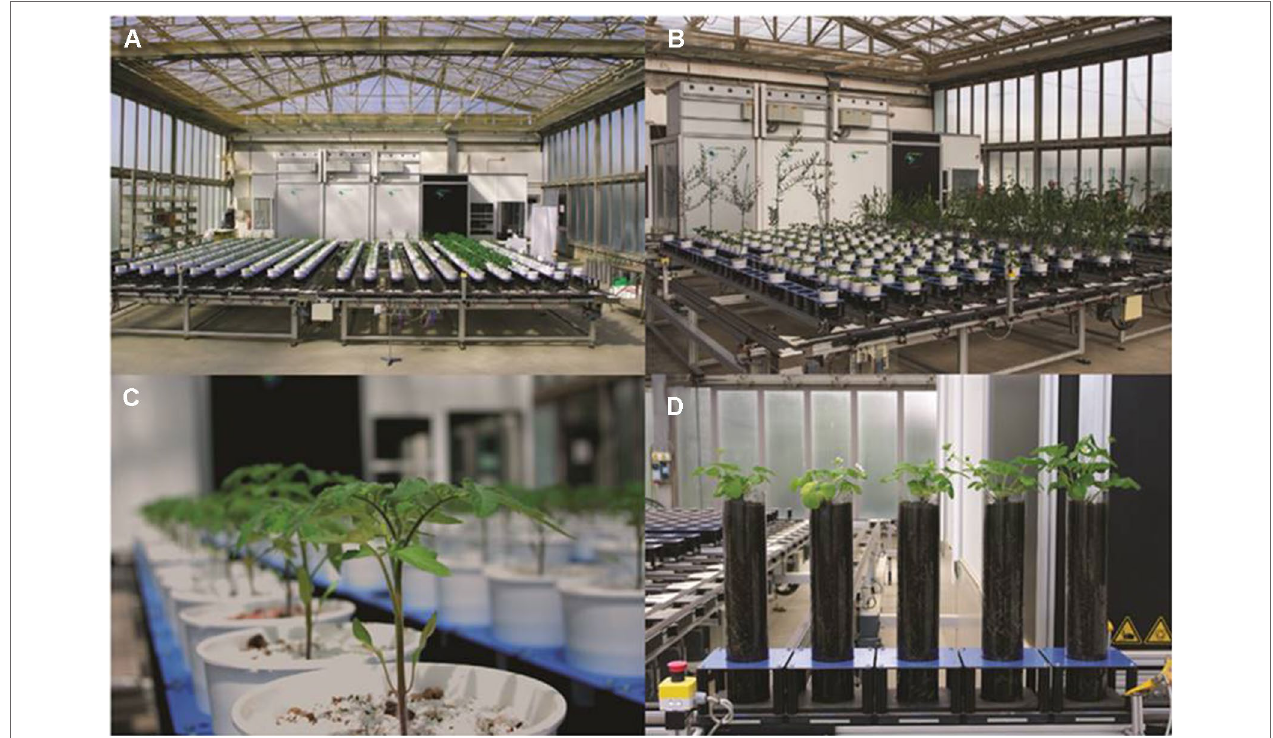
FIGURE 3 | The ALSIA greenhouse phenotyping facility (Basilicata, southern Italy) consisting of Scanalyzer 3D-systems which include conveyor belts (0.3 km and 500 cars) and image chambers: (A , B) the robot system for randomization of pots, consistent monitoring of pot weight, accurate application of water and imaging of plants; (C) phenotyping of tomato seedlings; and (D) phenotyping of root